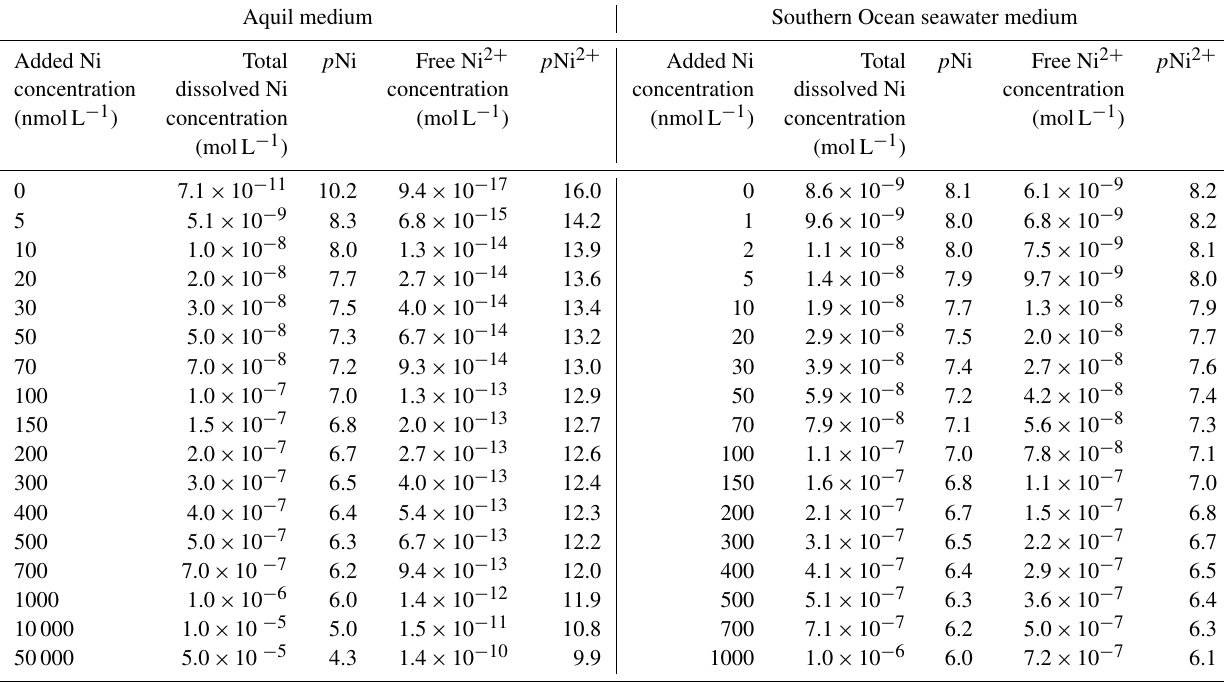
Table 1. The total dissolved concentrations and free ion concentrations of Ni in different media. Aquil